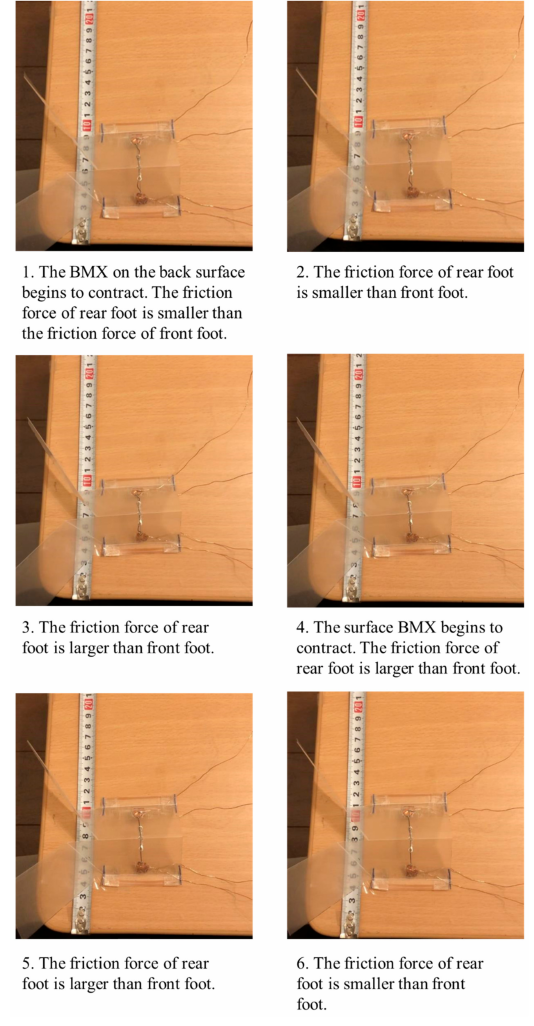
Figure 18. Walking experiment of the sheet type